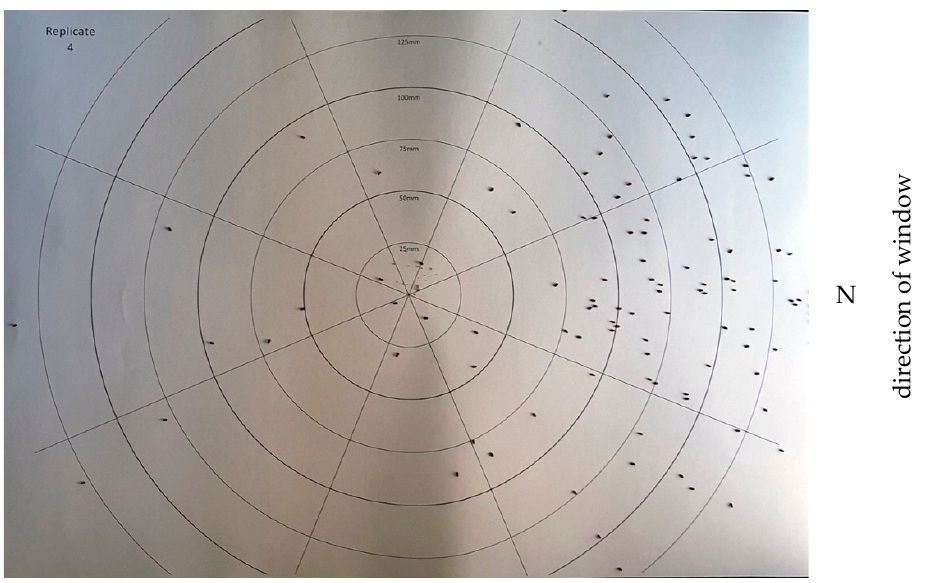
Figure 1. Example of a recording aid (experiment #1, replicate #4 in progress). Note the differences in light on the surface. Octant N is at the right.